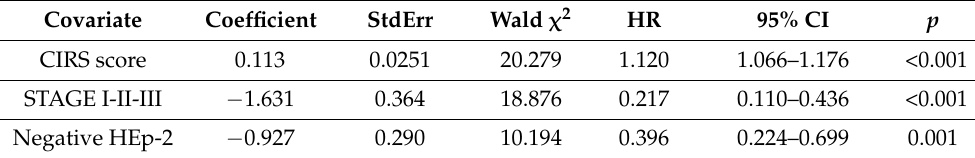
Table 4. The Cox-regression proportional hazards stepwise model estimates show that the hazard rate can be predicted from a linear combination of the covariates CIRS score, stage I-II-III (against stage IV), and a negative autoantibody test on HEp-2